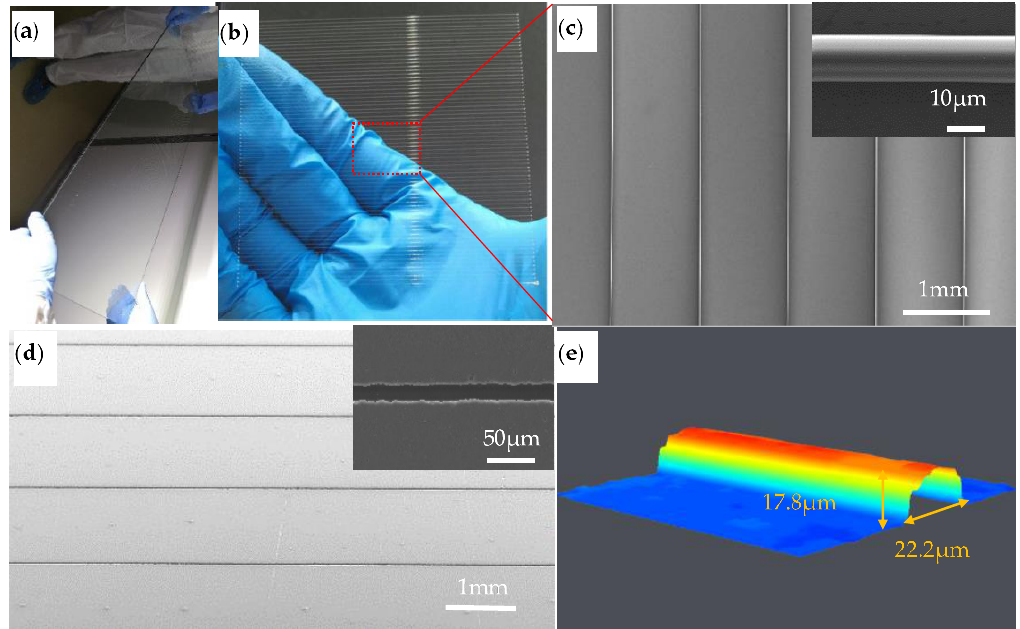
Figure 14. PMMA convex micromold printed using electric field-driven µ -3D printing: ( a ) printed PMMA large-area convex micromold (1200 mm × 800 mm); ( b ) printed PMMA large-area convex micromold (100 mm × 100 mm); ( c ) a partially enlarged SEM image of (b); ( d ) a replicated PDMS mold; ( e ) a partially enlarged volume microscope image of ( c ).